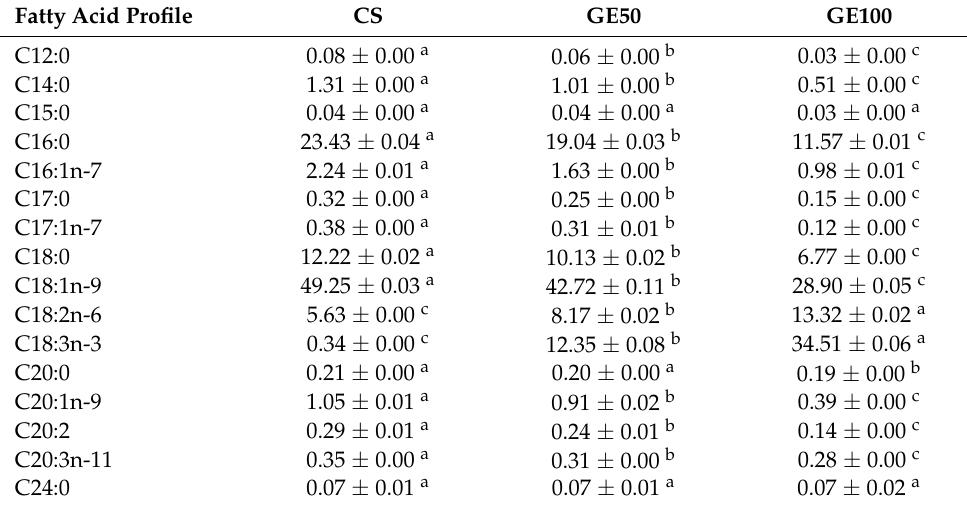
Table 2. Fatty acid profile of Frankfurt-type sausage formulates replacing pork backfat with gelled emulsion elaborated with peanut flour and flaxseed